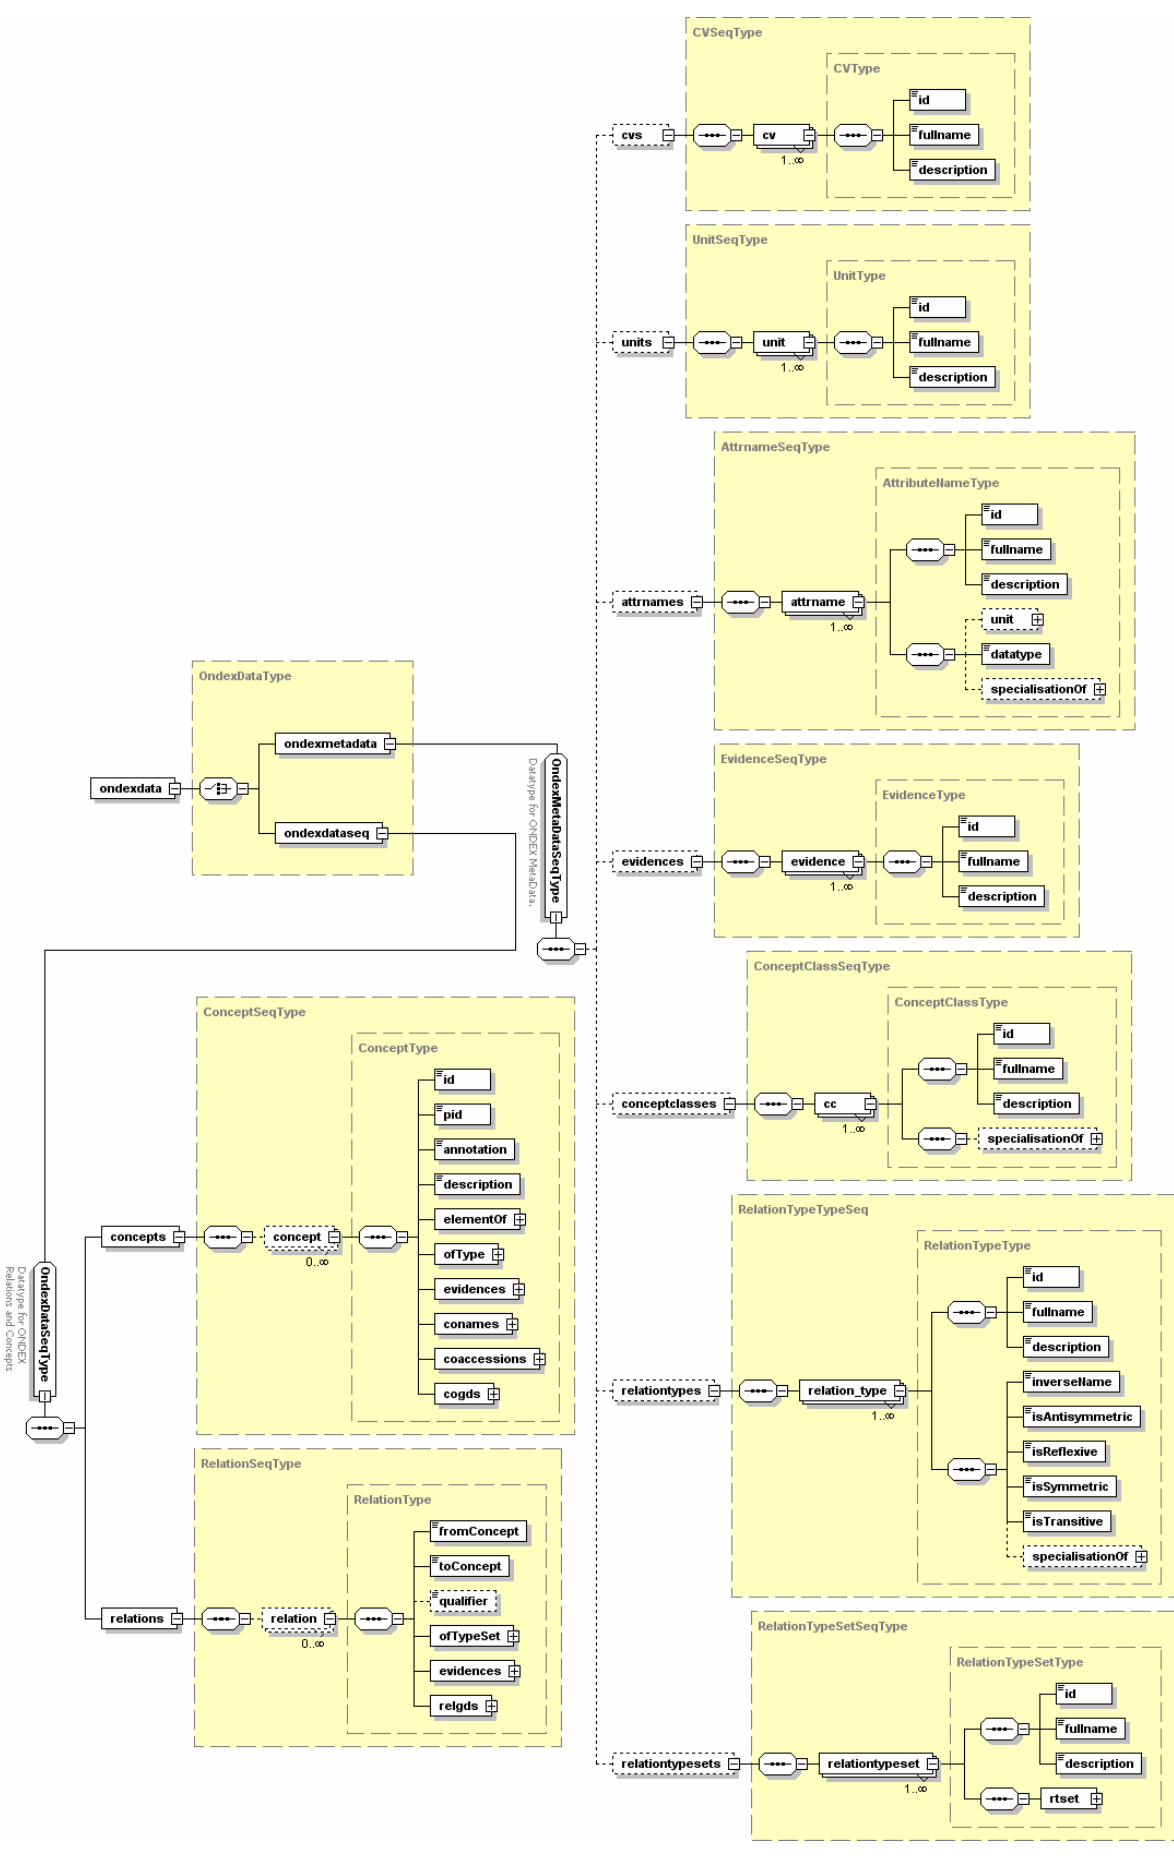
Journal of Integrative Bioinformatics, 4(3):62, Figure 1 Showing the XML Schema of OXL